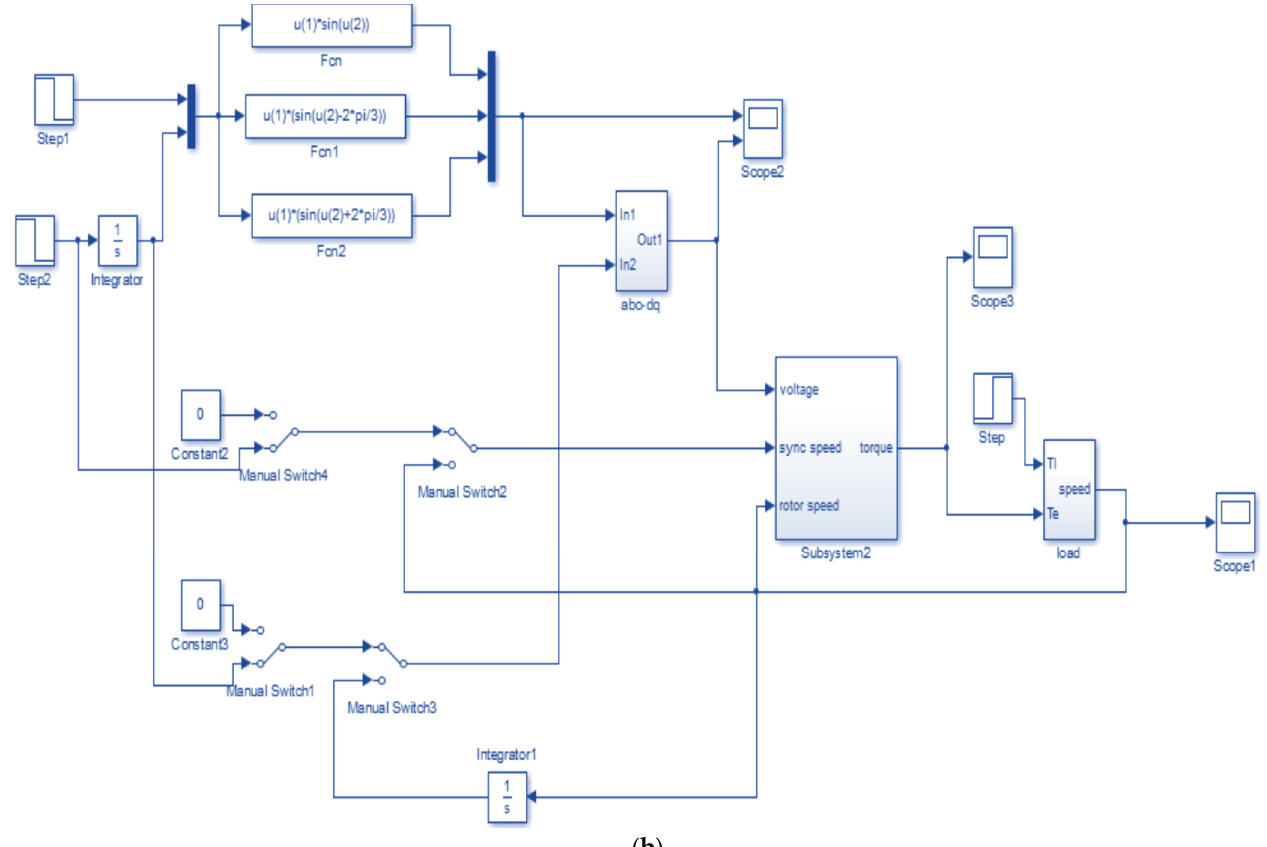
Figure 5. ( a ) Subsystem of dynamic modeling of three-phase induction machine. ( b ) Simulation of dynamic modeling of three-phase induction machine.